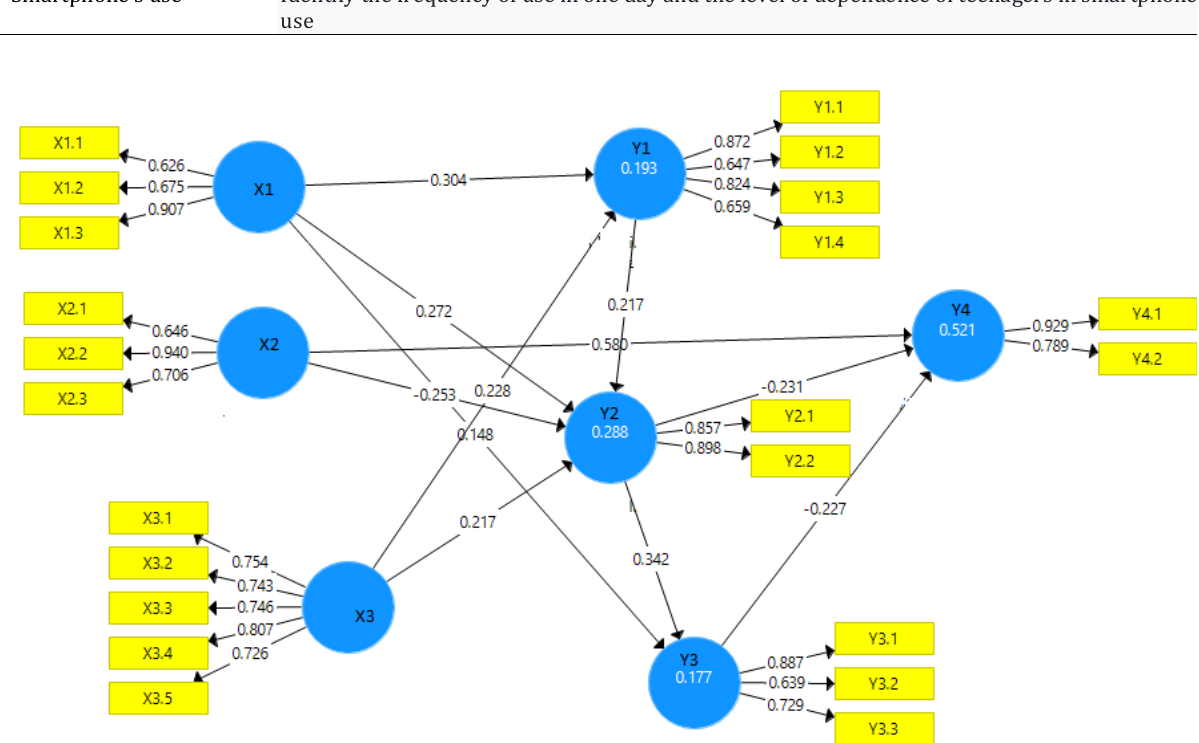
Figure 1. The Development o f Teenagers’ Safety Smartphone Use